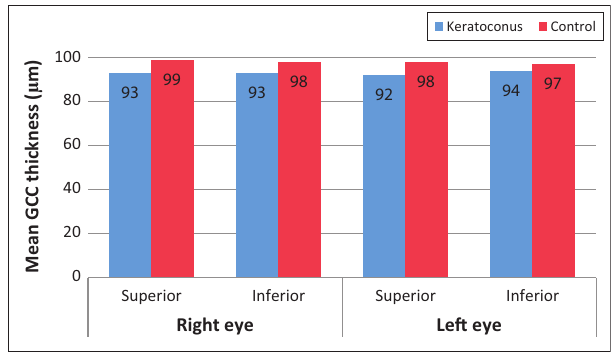
FIGURE 3: Ganglion cell complex thicknesses for the superior and inferior ganglion cell complex areas in the keratoconus and control